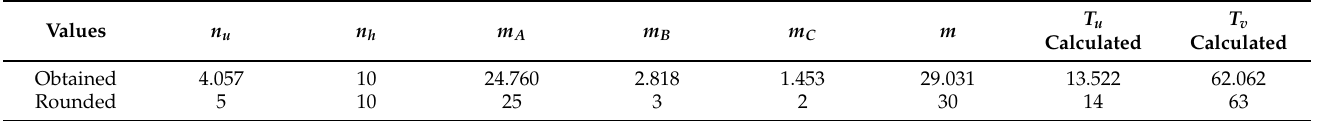
Table 7. Results of applying the formulas to the warehouse of the Kupfer company without area